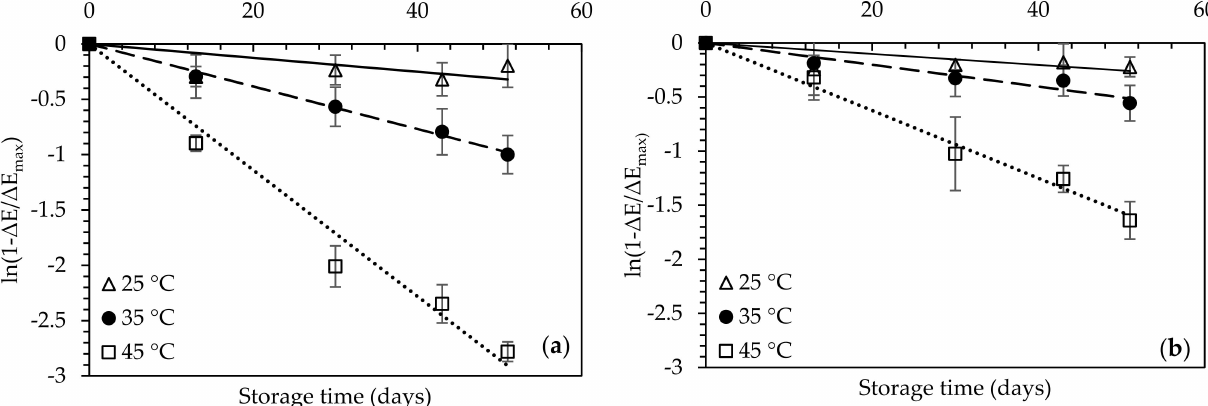
Figure 7. Kinetic modelling of the effect of the storage time and temperature (25 ◦ C ( (cid:52) ), 35 ◦ C ( color change of the ( a ) Control and ( b ) OD-pretreated air-dried fig halves. Error bars represent standard deviation from multiple replications of